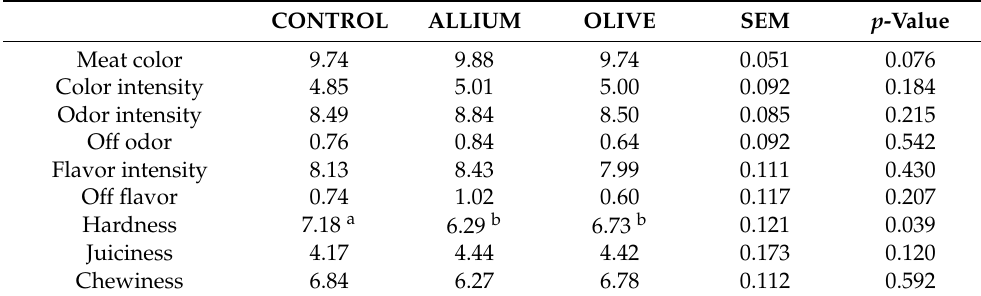
Table 6. Mean scores of the sensory attributes analyzed in cooked pork loin fed with three different treatments (0–10 cm